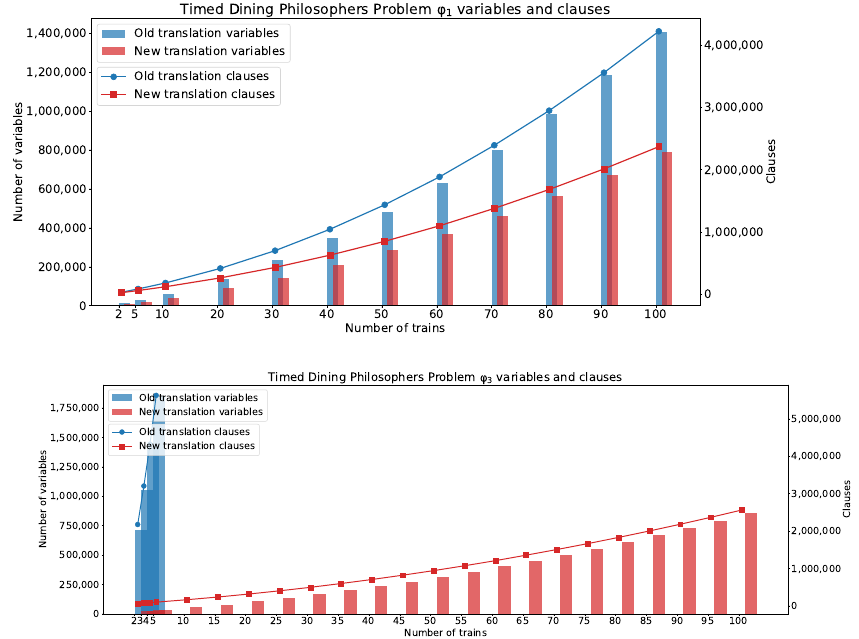
Figure 7. The TDPP with n philosophers clauses and variables: ϕ 1 and ϕ 3 .